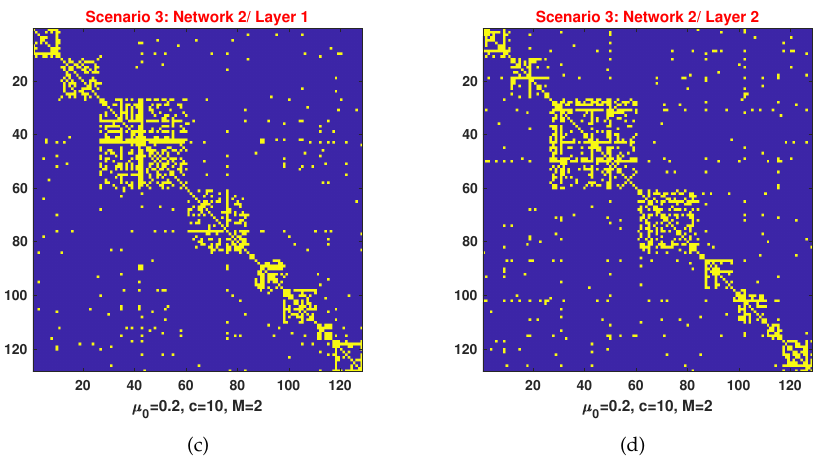
Figure 4. Examples showing some of the simulated 2-layer multiplex networks generated with n = 128, c = 10 and variable µ 0 . ( a , b ) Adjacency matrices with µ 0 = 0.1; ( c , d ) Adjacency matrices with µ 0 = 0.2.